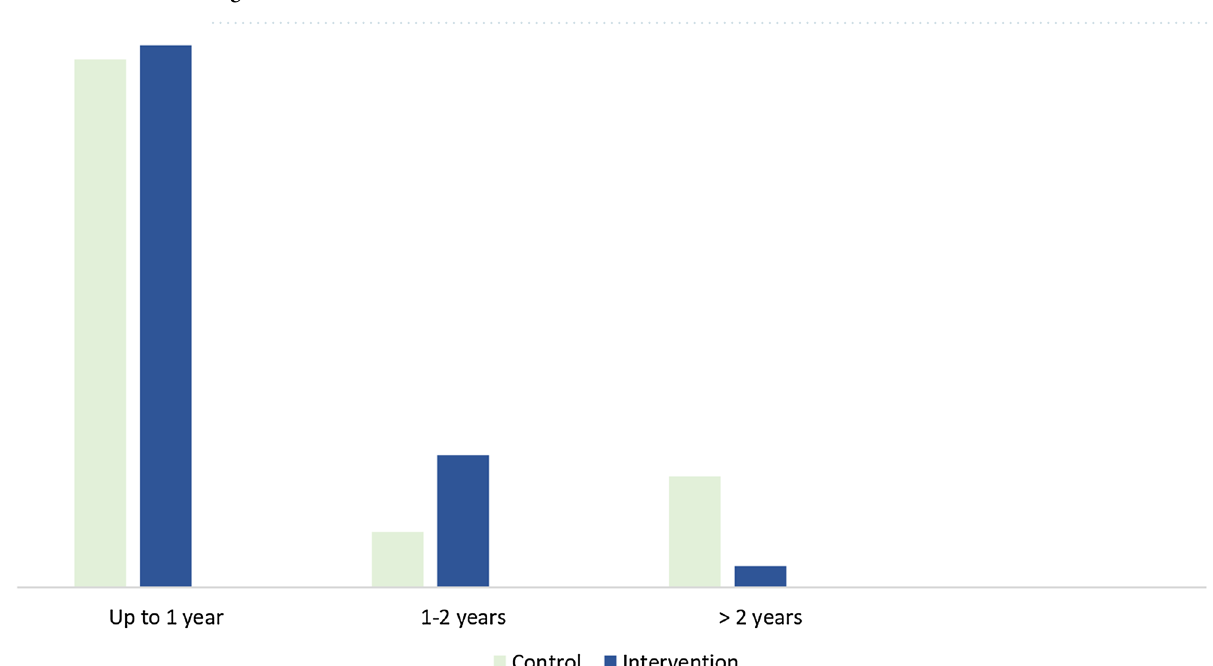
Figure 2. Clinical treatment length after the internet-based